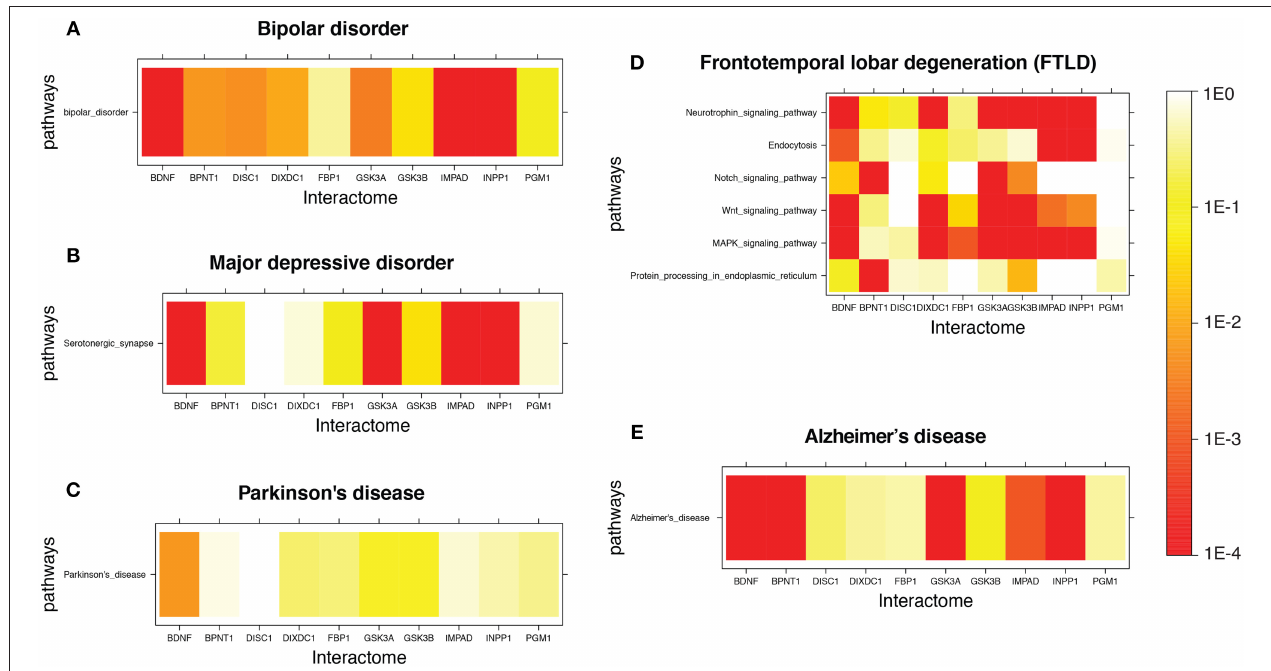
FIGURE 1 | Heatmap for Lithium-sensitive enzyme interactome enrichment in disease-related pathways. The empirical enrichment p -value was calculated for each set of disease-associated genes. (A,B) are disorders where lithium treatment has proved to be effective and both show high enrichment. (C,D) are diseases where the effect of lithium treatment is unknown. (C) shows relatively low enrichment while (D) shows high enrichment. (E) is a disease where there is suggestive but not conclusive evidence for possible effectiveness of lithium therapy and shows high